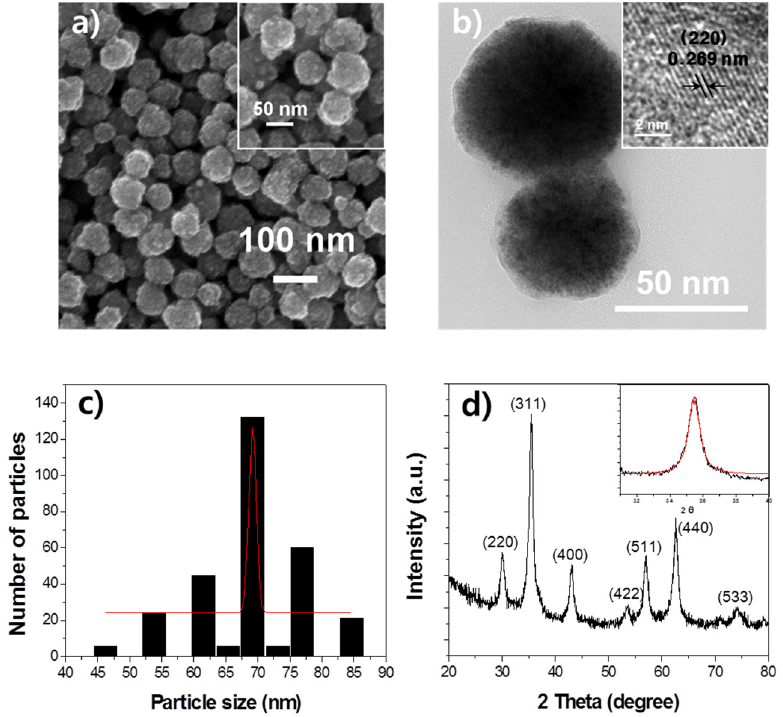
Figure 1. Morphology and crystal structure of the CoFe 2 O 4 nanoparticle. ( a ) Field-emission scanning electron microscopy image and ( b ) transmission electron microscopy micrographs of the CoFe 2 O 4 nanoparticle; ( c ) Histogram for the particle size distribution of the CoFe 2 O 4 nanoparticles; ( d ) X-ray diffraction pattern of the CoFe 2 O 4 nanoparticles.